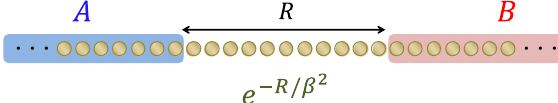
FIG. 2. Schematic of 1D entanglement clustering. In the obtained bound (2), the subset dependence e O ðj A jþj B jÞ prohibits its application to the upper bound of the entanglement between two large blocks. In one-dimensional systems, this problem can be resolved to obtain better subset dependence, as in Eq. (3). Here, the characteristic length of bipartite entanglement becomes O ð β 2 Þ instead of O ð β Þ